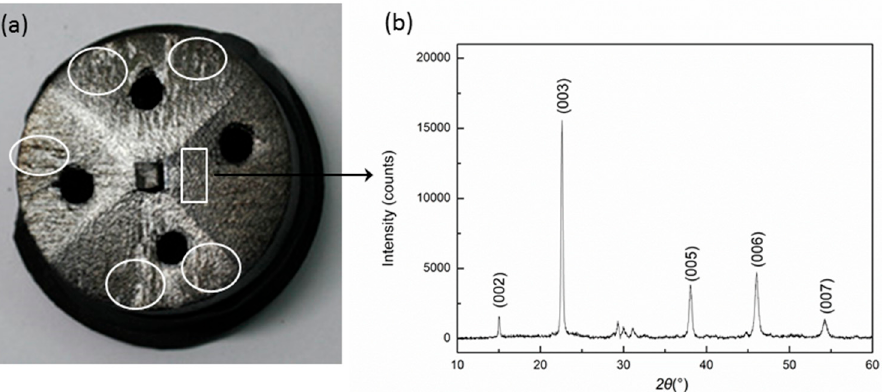
Figure 3. ( a ) The top surface macroscopic features of the as-grown drilled SmBCO single domain sample with a diameter of 32 mm; ( b ) the X-ray diffraction pattern of the drilled sample.